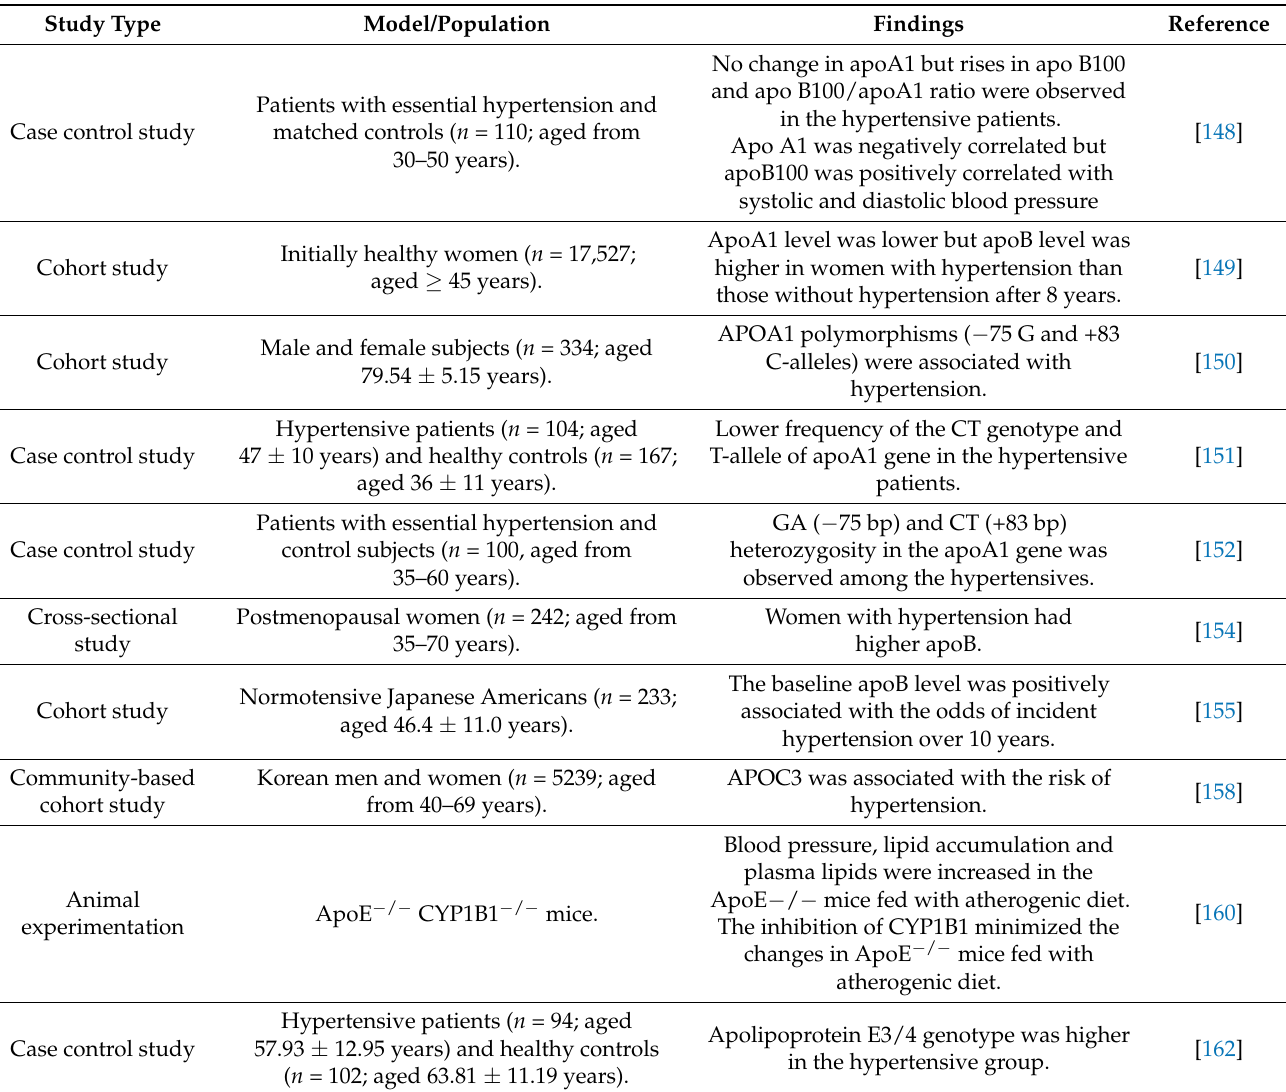
Table 10. The relationship between apolipoprotein and blood